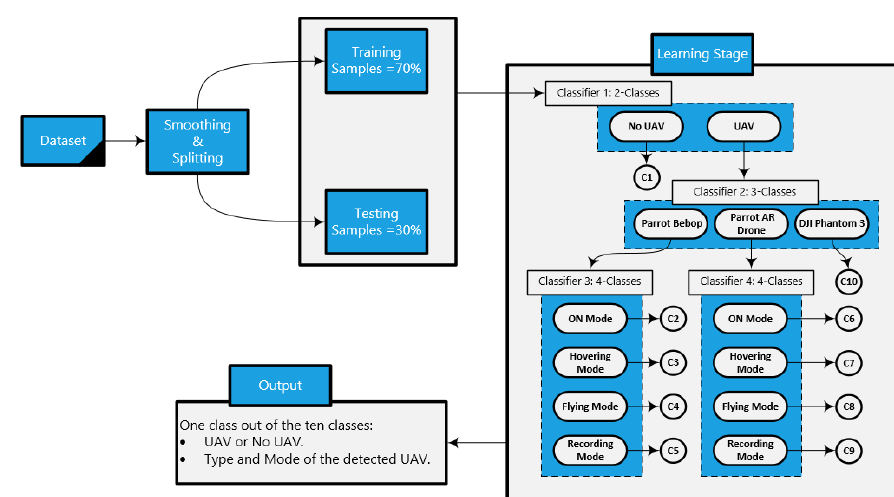
Figure 7. Our hierarchical learning approach consists of dividing the dataset into training and testing data stage and a learning stage with four classifiers to specify the class of any